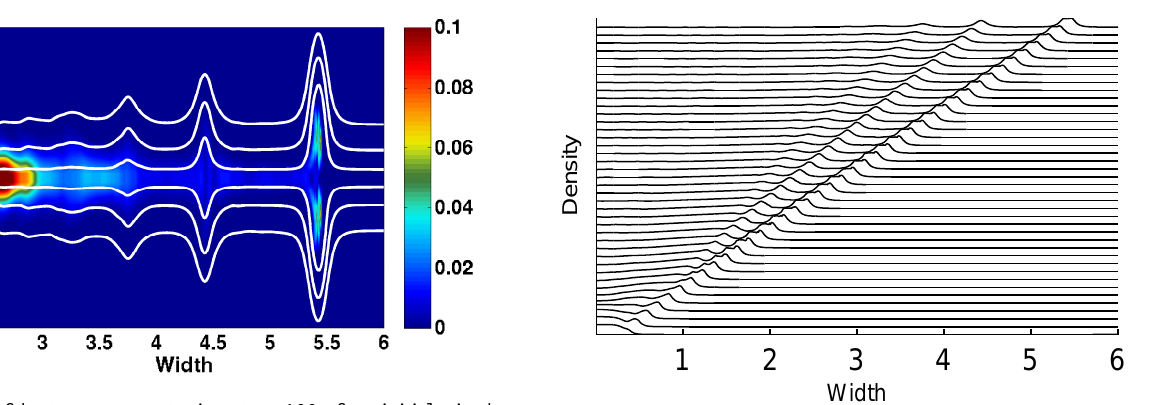
Fig. 4. Plot of the tracer concentration at t = 100s for a initial mixed layer symmetric about a mid-depth pycnocline. The colorbar was saturated at 10% of the maximum. Six contours of density are over- layed in order to identify the location of the internal waves. No- tice that the distribution is entirely symmetric about the mid-depth. Three perfectly symmetric mode-2 waves are clearly observed.